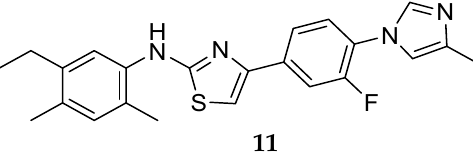
Figure 11. Structure of NGP555 ( 11 ).